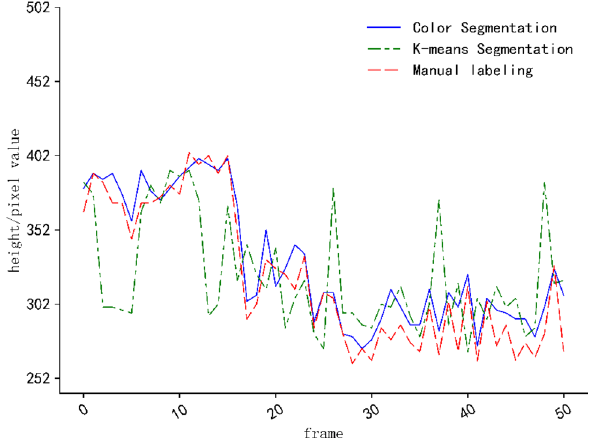
Fig. 7 Wheat height line chart